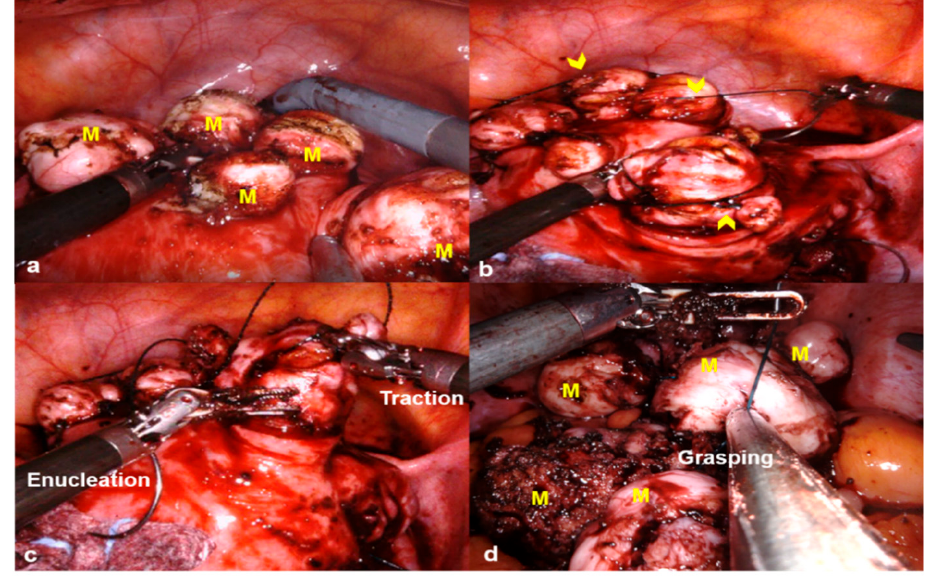
Figure 1. Locking suture on myoma (LSOM) technique. ( a ) Multiple myomas (M) are exposed after an incision on the uterine wall. ( b ) Locking sutures with 1 ‐ 0 V ‐ Loc (arrowheads) are made on the exposed uterine myomas. ( c ) During the myoma enucleation process, the myoma traction is easily performed by grasping the thread with a mega suture needle holder. ( d ) The retrieved myomas are easily removed by simply grasping the thread with a laparoscopic needle holder.